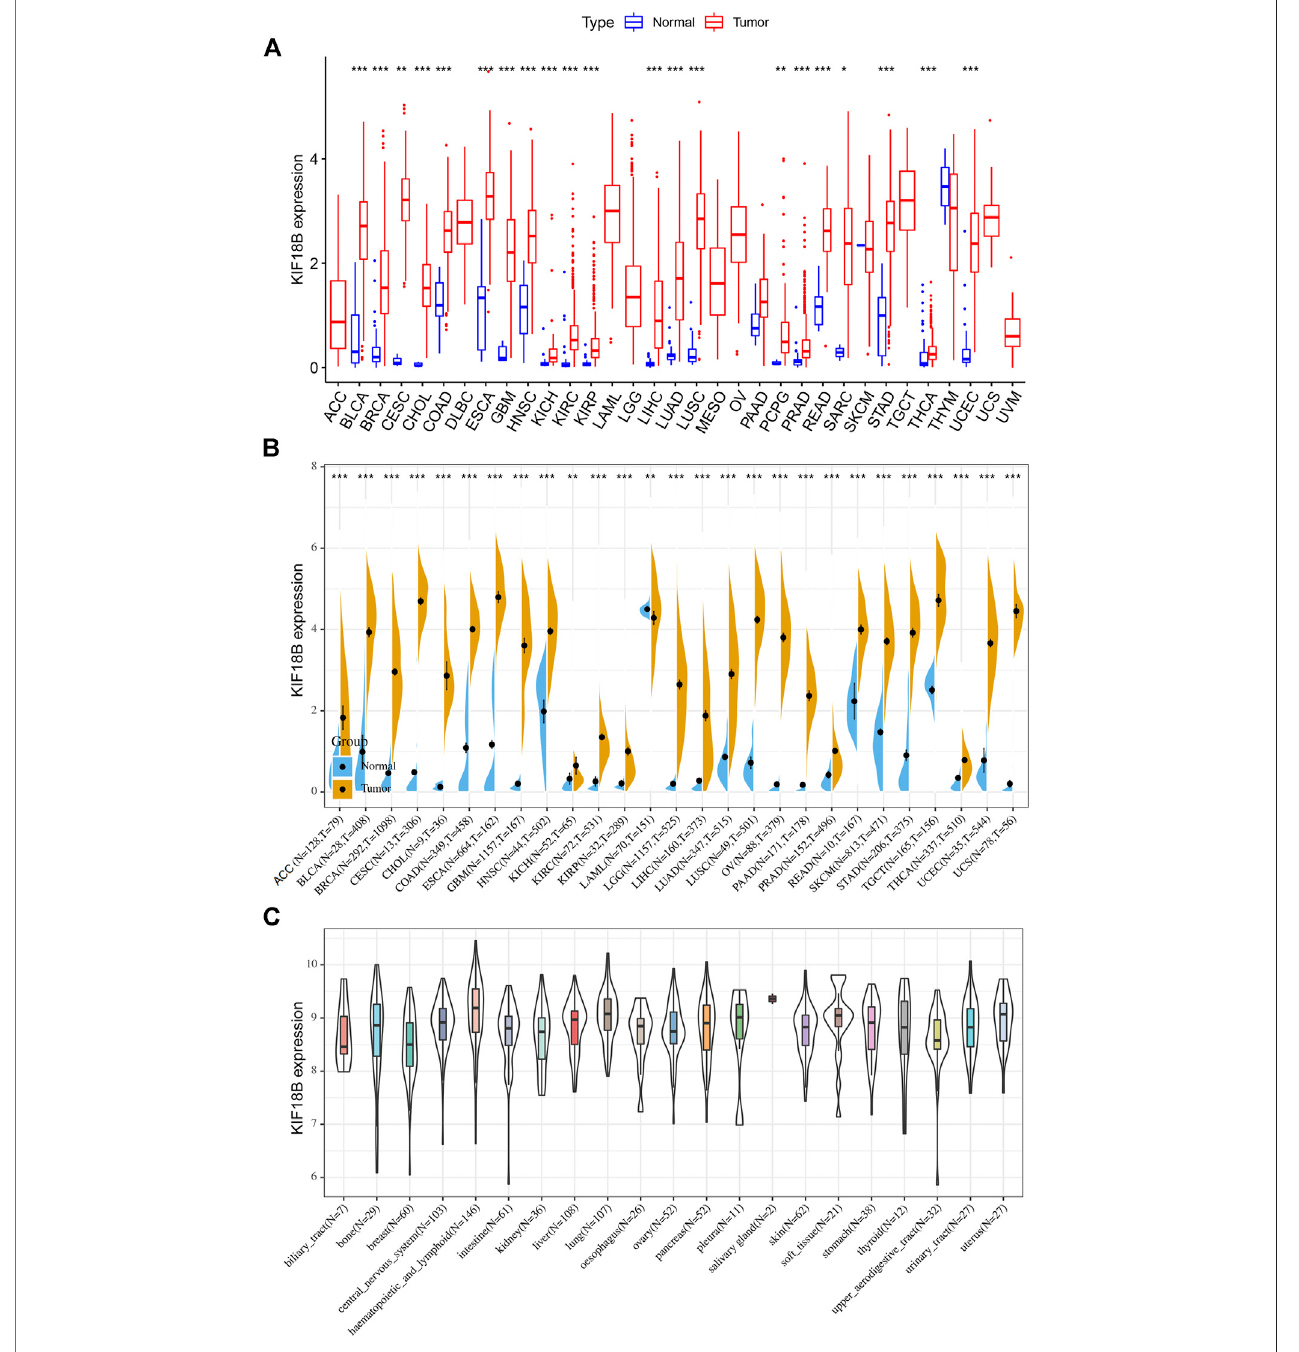
FIGURE 1 | The transcription levels of KIF18B in various cancers. (A) The evaluation of KIF18B mRNA in 33 types of cancers from TCGA database. (B) The evaluationofKIF18BmRNAin27typesofcancersbyintegratingnormaltissuedatafromGTExwithtumortissuedatafromTCGA. (C) TheevaluationofKIF18BmRNAin the cancer cell lines of 21 tissues using the CCLE database. * indicates p < 0.05, ** indicates p < 0.01, *** indicates p <